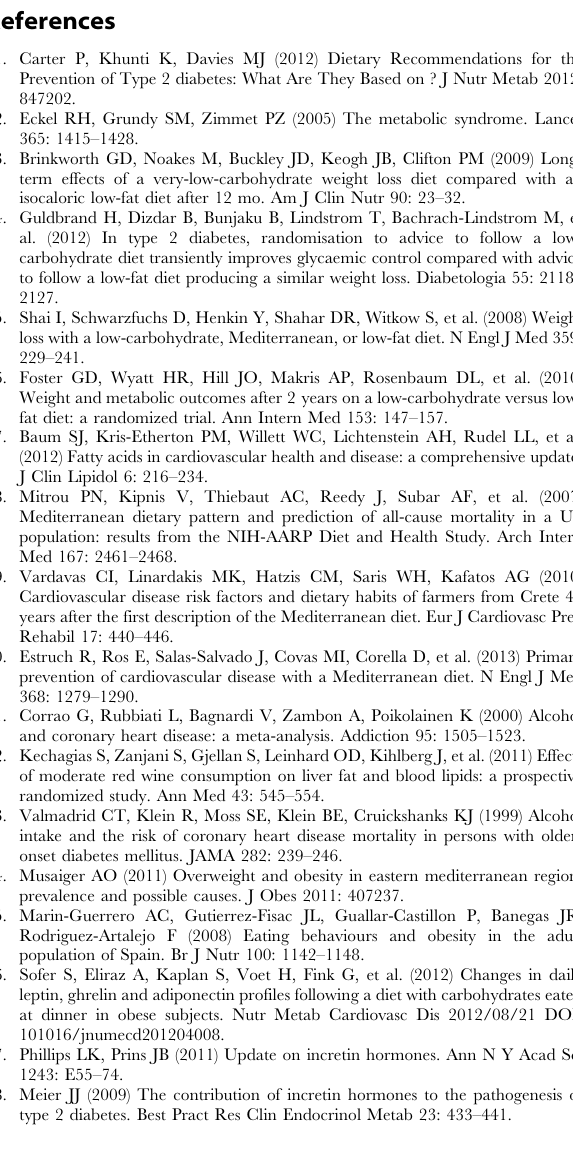
Figure S2 Effects on LDL-cholesterol. All other information same as Figure S1. Figure S3 Effects on HDL-cholesterol. All other informa- tion same as Figure S1. Figure S4 Effects on leptin. All other information same as Figure